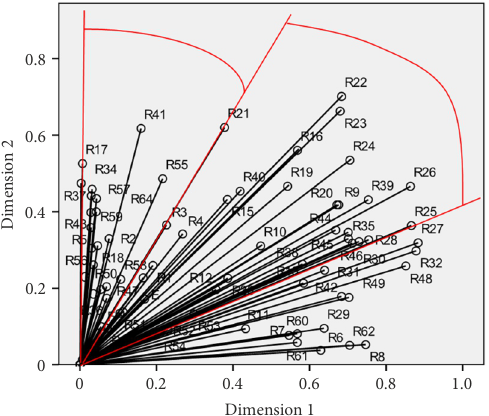
Figure 1. Representation of measures to discriminate vari- ables at the two-dimensional level (see variables nomenclature in Tables 3 and 4)